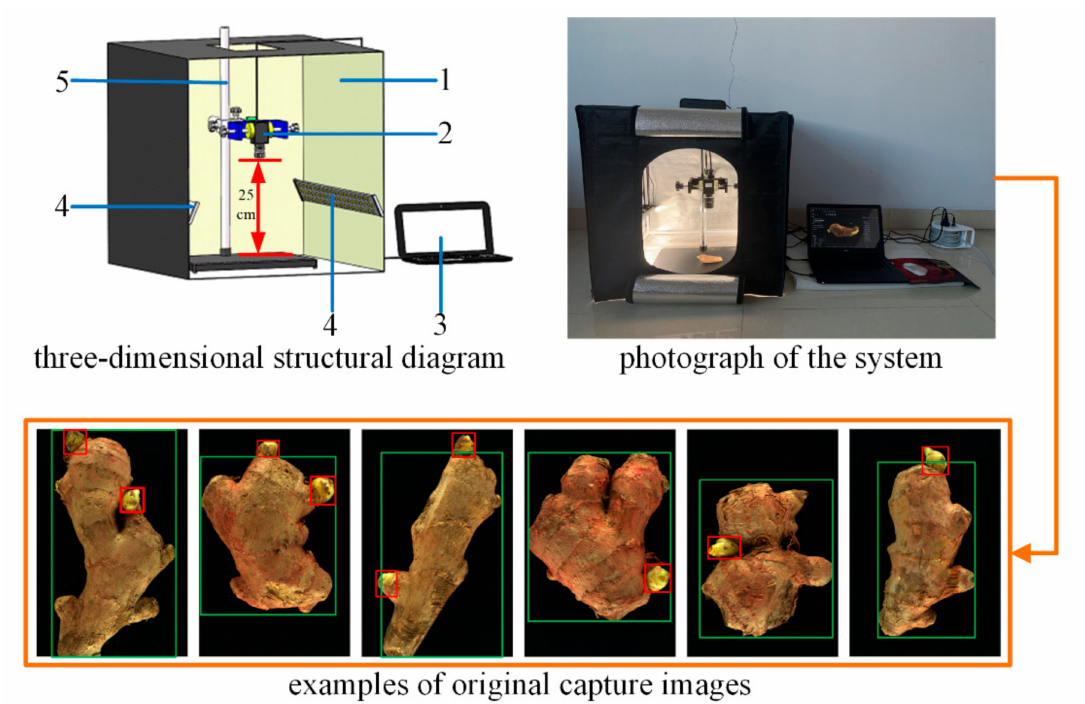
Figure 2. Schematic diagram of the images acquisition and annotation